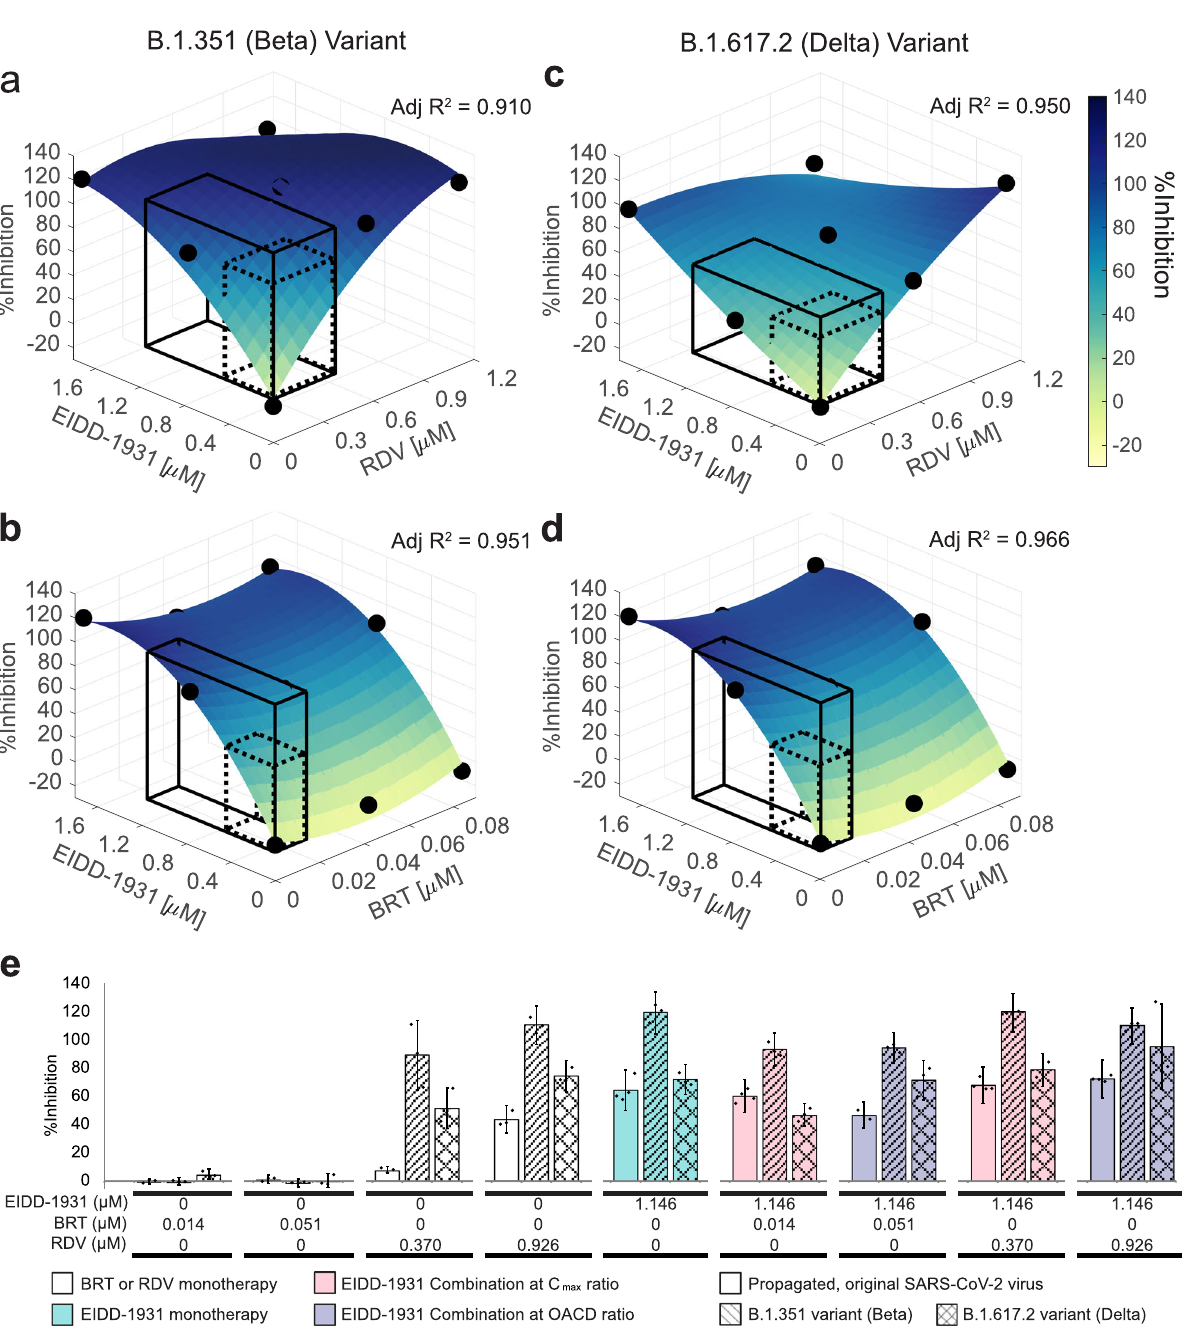
Fig. 4 Validation of EIDD-1931 drug interactions affecting %Inhibition in SARS-CoV-2 B.1.351 and B.1.617.2 variants. a – d Surface plots of EIDD-1931 interactions with remdesivir (RDV) and baricitinib (BRT) in the validation interaction space, clinically actionable interaction space (black, solid line border) and the interaction space from the IDentif.AI-x analysis (black, dotted line border). All experiments were performed with N = 3 replicates, which were independently included in the surface construction. Black, round markers indicate an average %Inhibition of the replicates for each treatment. Adjusted R 2 (Adj R 2 ) indicates goodness of the fi t for each interaction surface. The experiments with SARS- CoV-2 B.1.351 variant ( a , b ), and B.1.617.2 variant ( c , d ) were performed in two independent sets. e %Inhibition against the propagated, original SARS-CoV-2 strain (bars with block fi lling), B.1.351 variant (bars with line fi lling) and B.1.617.2 variant (bars with cross lines fi lling) of 10% C max EIDD-1931 in monotherapy (green) and in a combination with RDV and BRT at two concentration ratios: the ratio dictated by the C max values of the drugs (C max ratio; pink) and the ratio tested in the IDentif.AI-x experimental set (OACD ratio; purple). Black markers indicate individual data points. Error bars represent propagated standard deviation (s.d). Of note, this propagated s.d. did not arise from the replicates ’ spread, but from plate-to-plate variation (s.d. of the controls). No statistically signi fi cant difference was detected with Kruskal – Wallis test when followed by Dunn ’ s post hoc